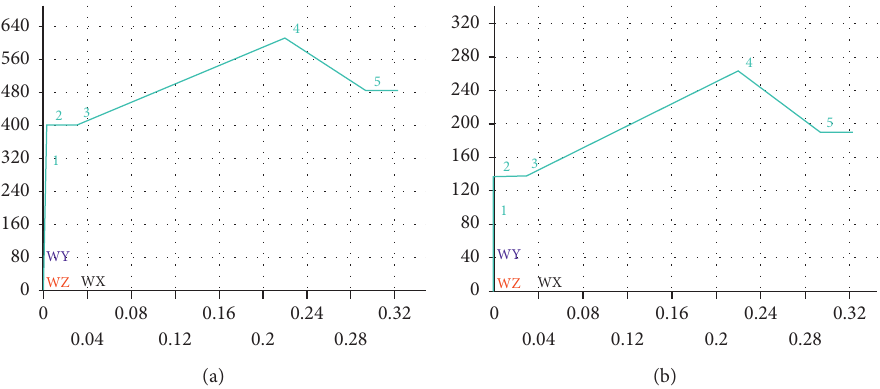
Figure 14: Constitutive model of steel material. (a) Steel material of Q345. (b) Low-yield-point steel of